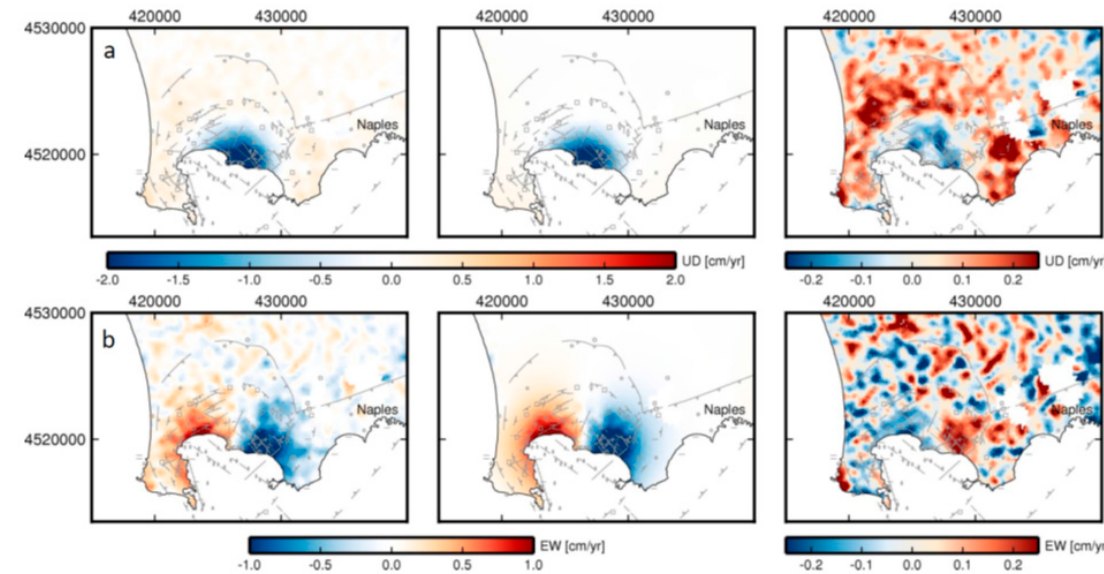
Figure 7. ( a ) Observed vertical displacement rate (left), cm / yr, for the subsidence period, 1993–1999; modelled vertical displacement rate from inversion (center); and residual of observed and modelled displacements (right). ( b ) Observed EW displacement rate (left), cm / yr, 1993–1999; modelled EW displacement from inversion (center); and residual of observed and modelled displacements (right). Images were saturated at the corresponding scales in order to improve comparison and highlight di ff erences among panels [53].